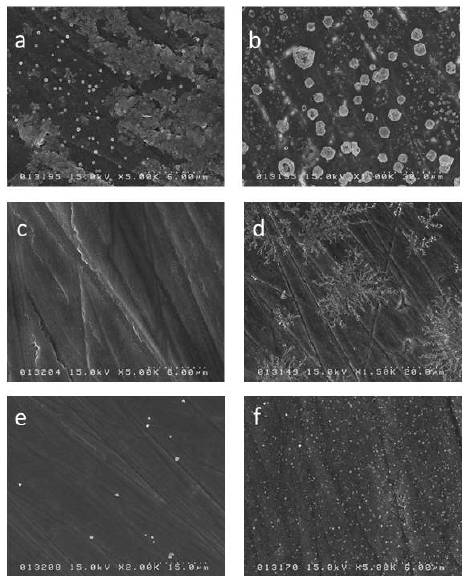
Figure 5. Scanning electron microscope (SEM) image for the surface of the enamel specimens: ( a ) SDF 24 h; ( b ) SDF 2 weeks; ( c ) SDF + GSH 24 h; ( d ) SDF + GSH 2 weeks; ( e ) SDF + KI 24 h; and ( f ) SDF + KI 2 weeks.